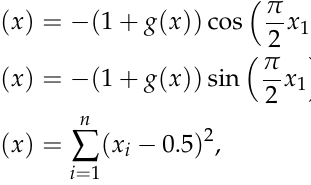
Figure 18. Different iterations of the ∆ 2 bootstrapping